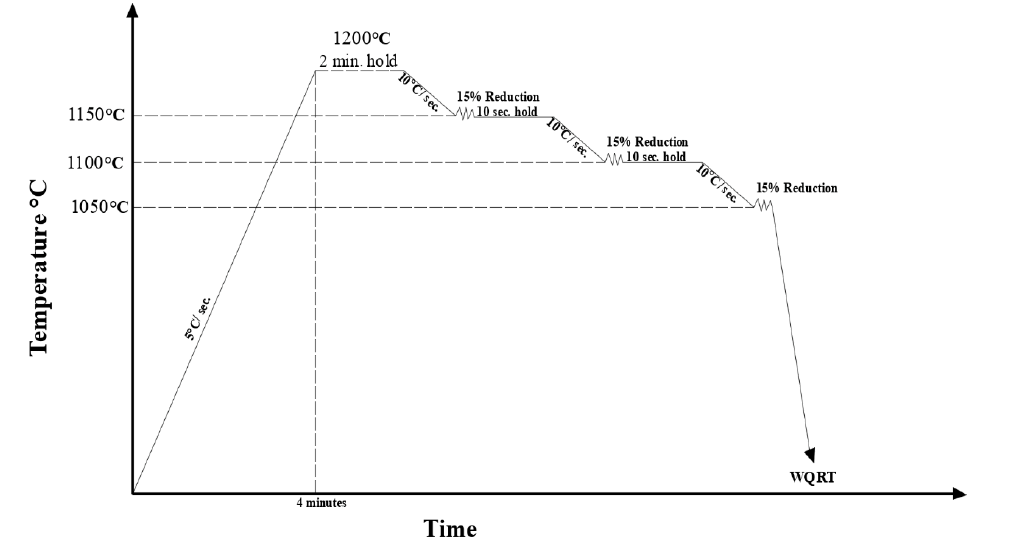
Figure 6. Thermomechanical schedules used in hot compression deformations with 15% reductions.